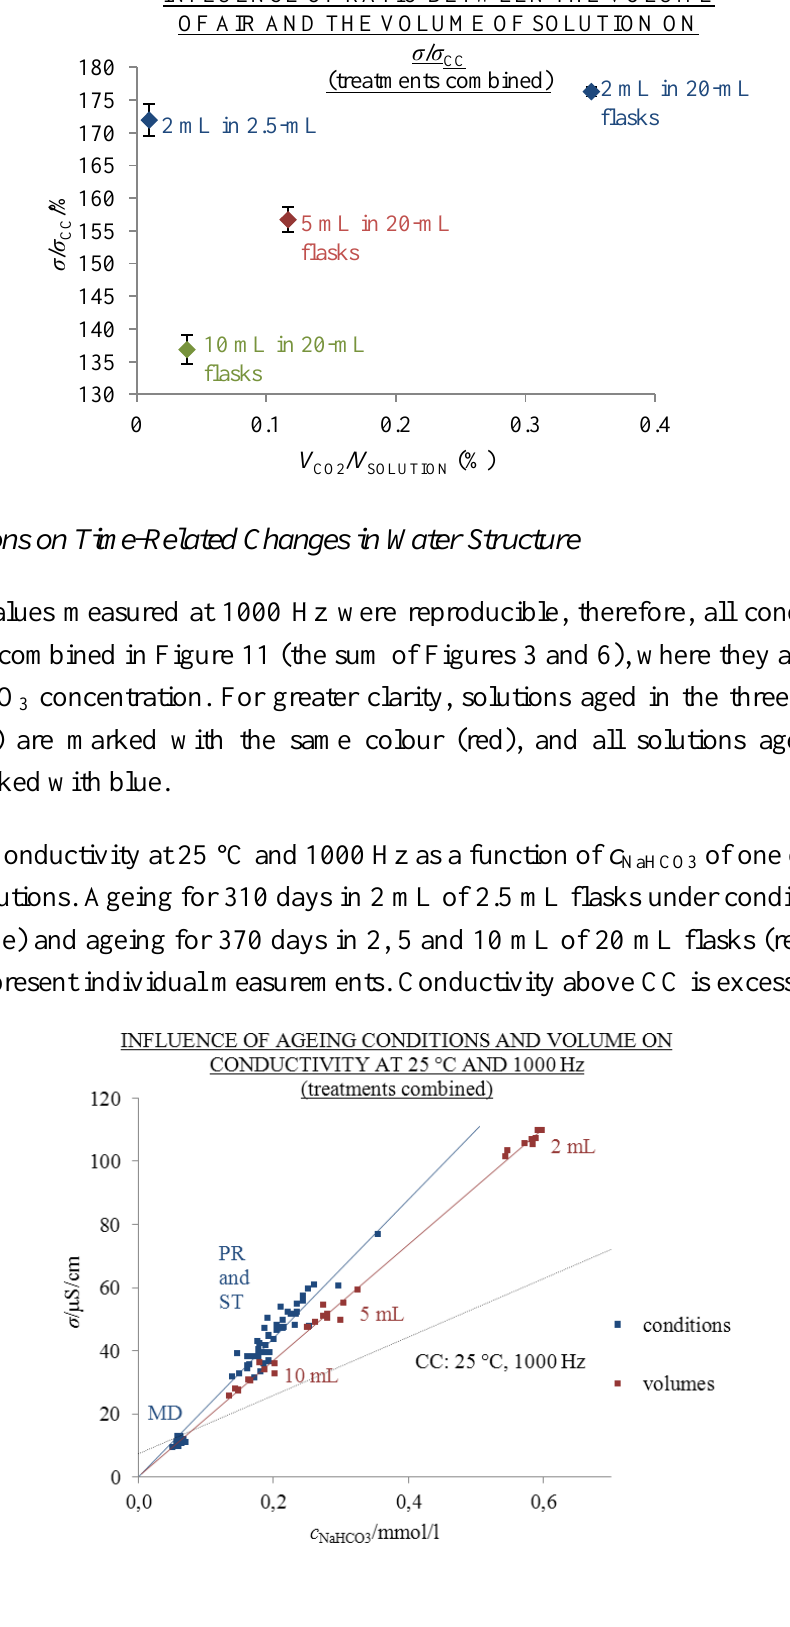
Figure 10. Average coefficients σ / σ of ratio of the volume of air above solution and the volume of solution ( V treatments are combined. Solutions aged 310 or 370 days under the condition PR. Ordinate starts at 130%. N [/]: 0.01% of V